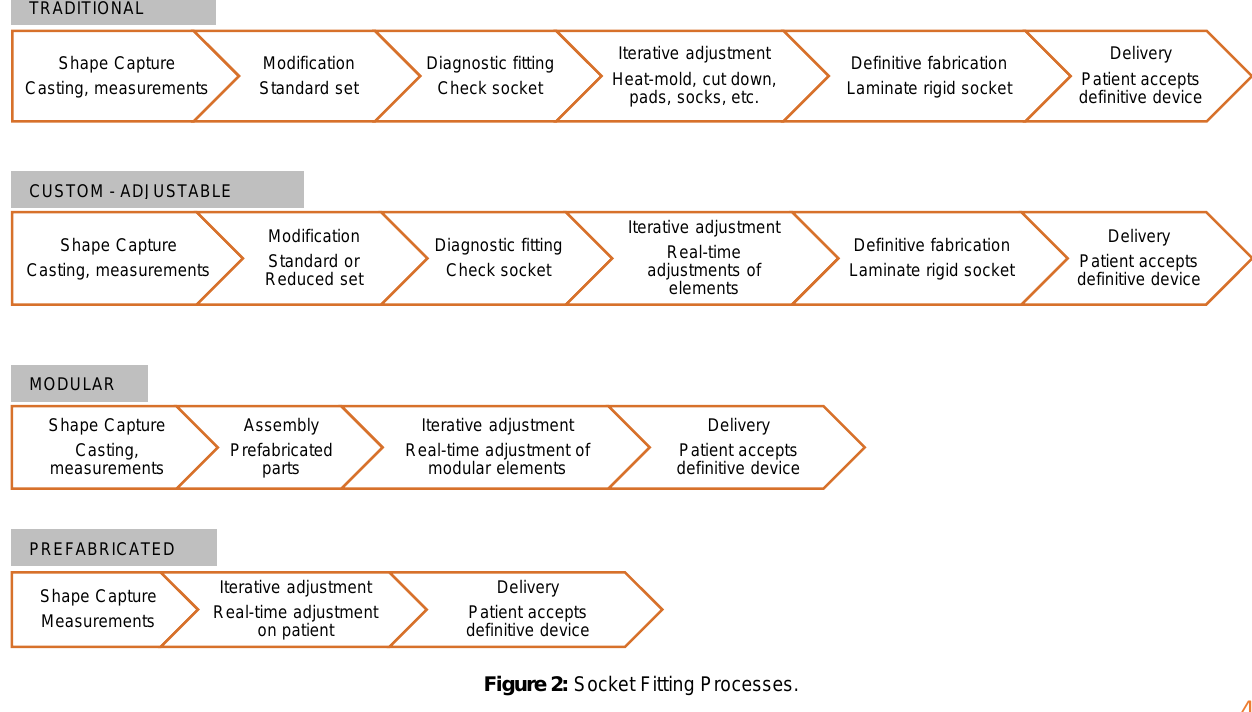
Figure 2: Socket Fitting